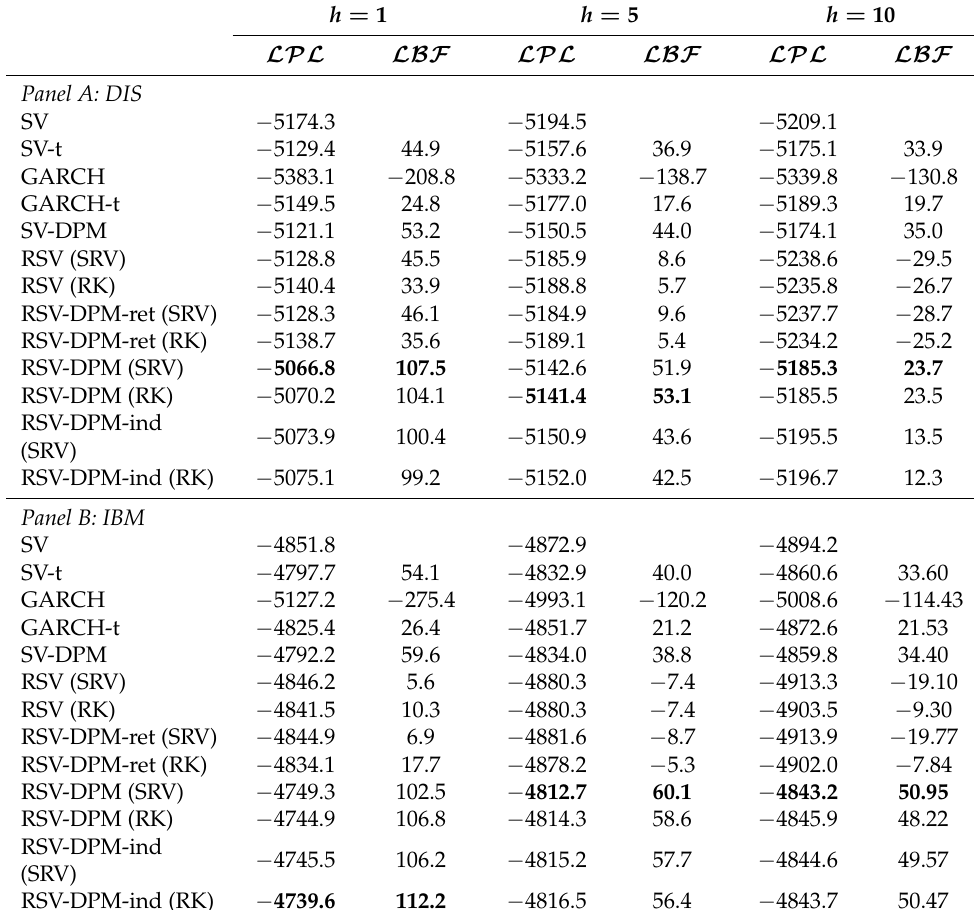
Table 3. Return density